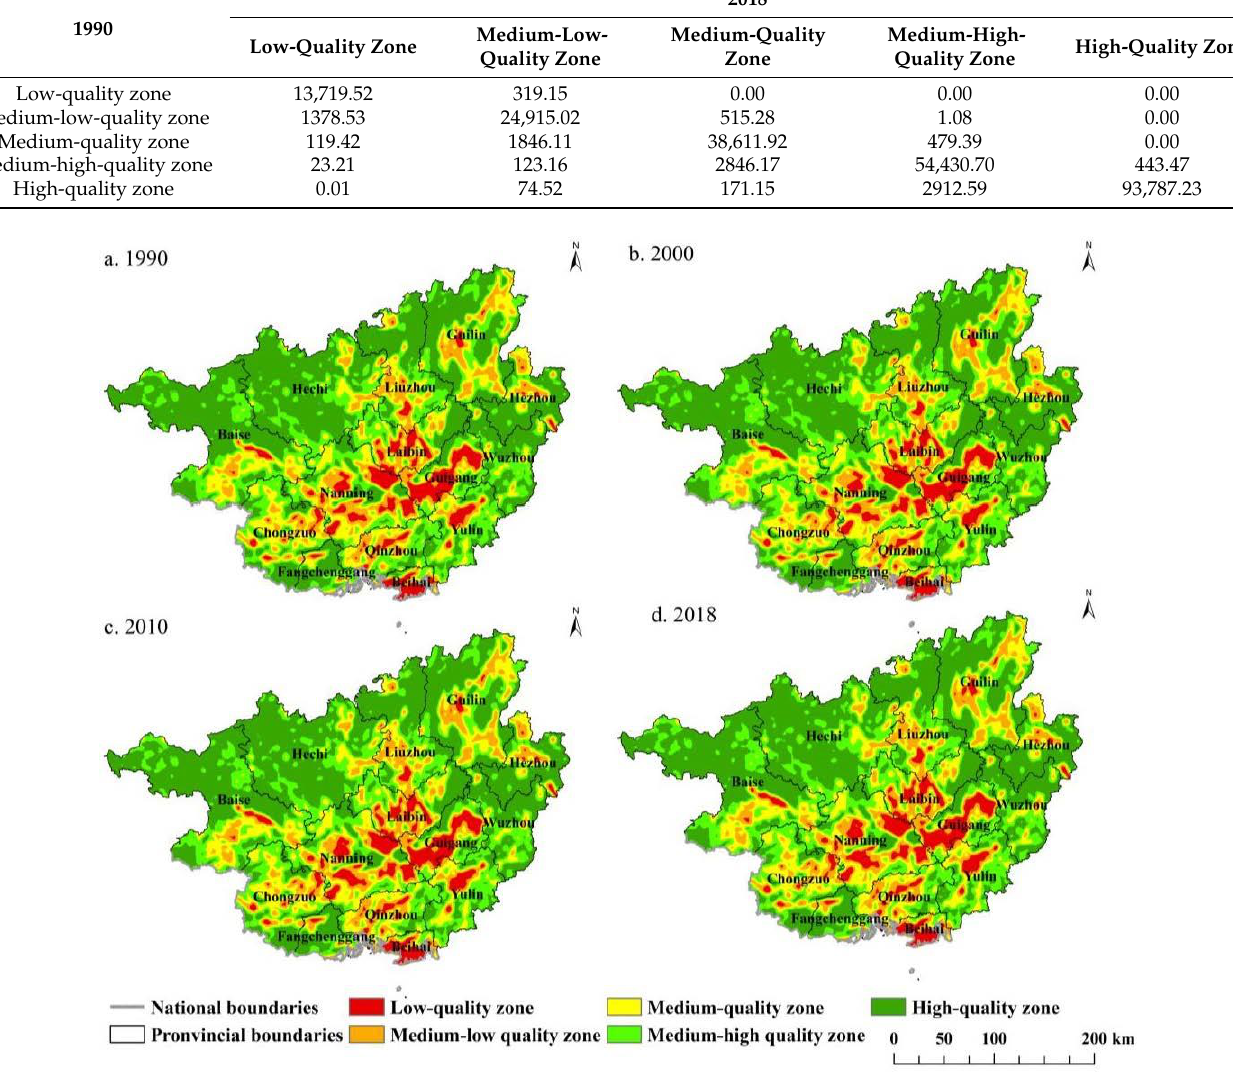
Figure 4. Spatial distribution of eco-environmental quality zones in Guangxi, China, during 1990–2018.